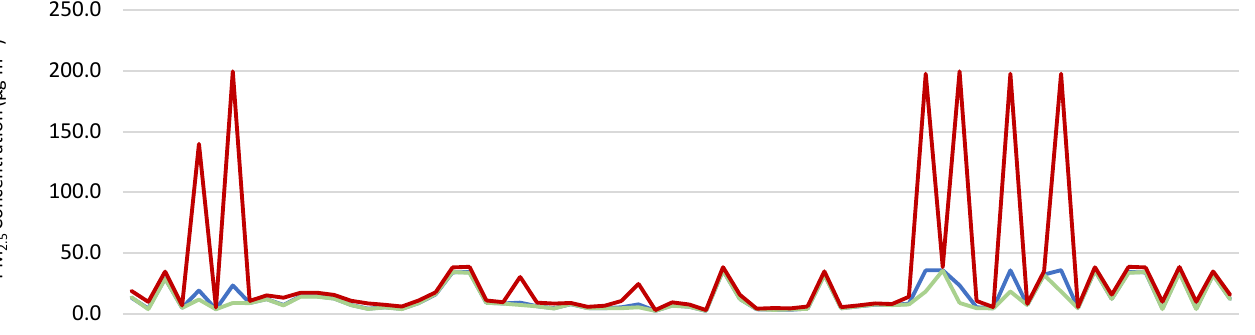
Figure 5. PM 2.5 concentration ( μ g·m − 3 ) indoors.